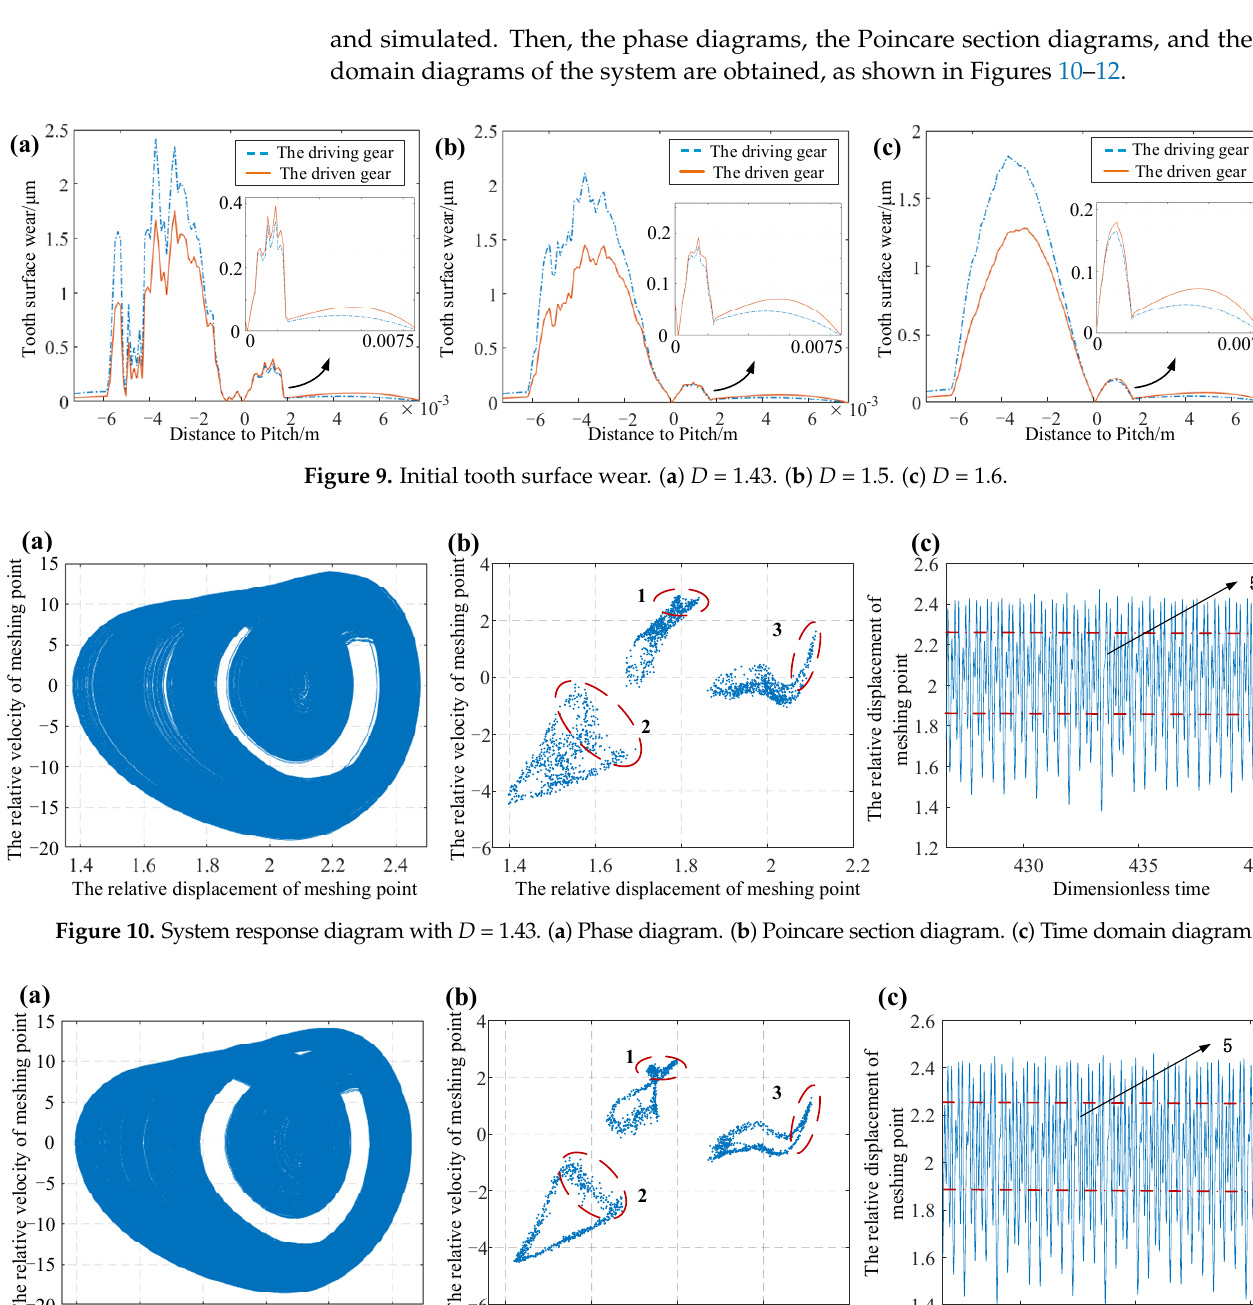
Figure 10. System response diagram with D = 1.43. ( a ) Phase diagram. ( b ) Poincare section diagram. ( c ) Time domain diagram.